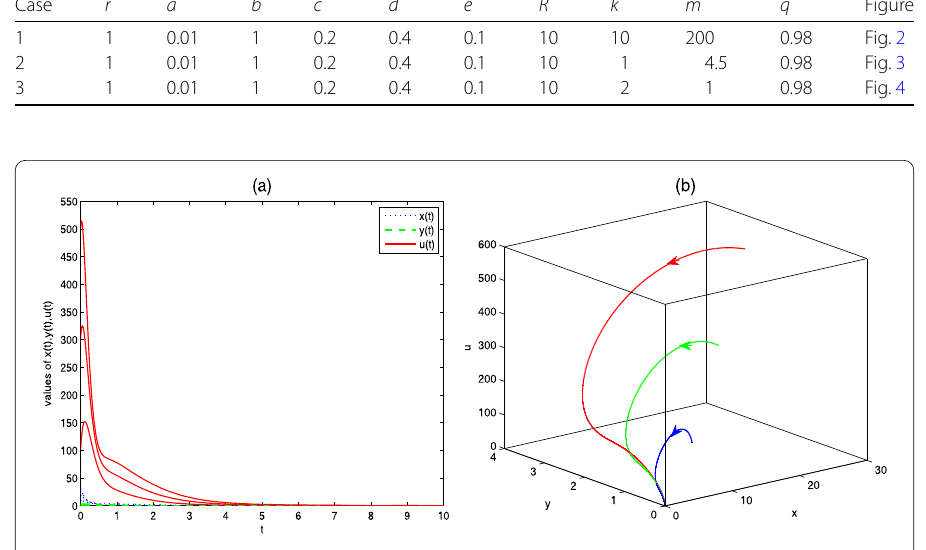
Figure 2 Global asymptotic stability of the trivial equilibrium point E 0 for different initial